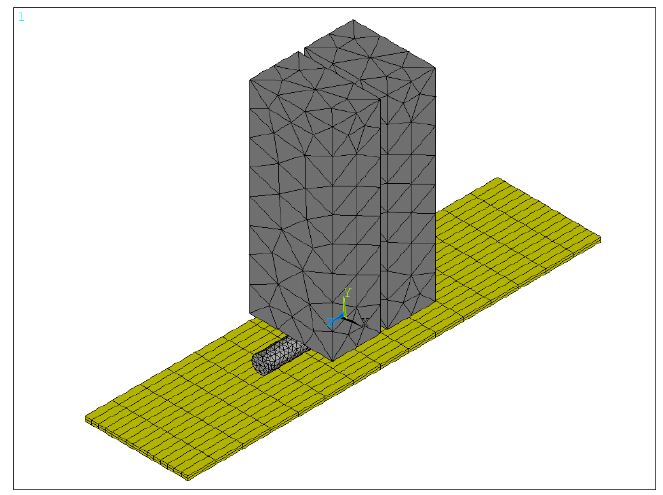
Figure 11. Finite element model of the welding process.